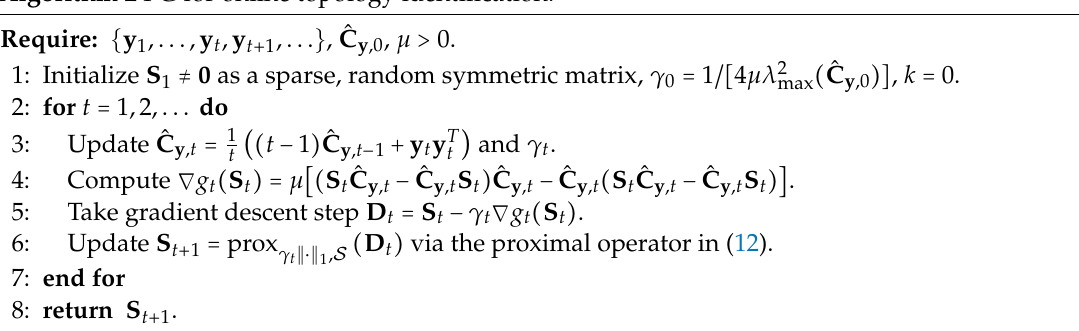
Algorithm 2 PG for online topology